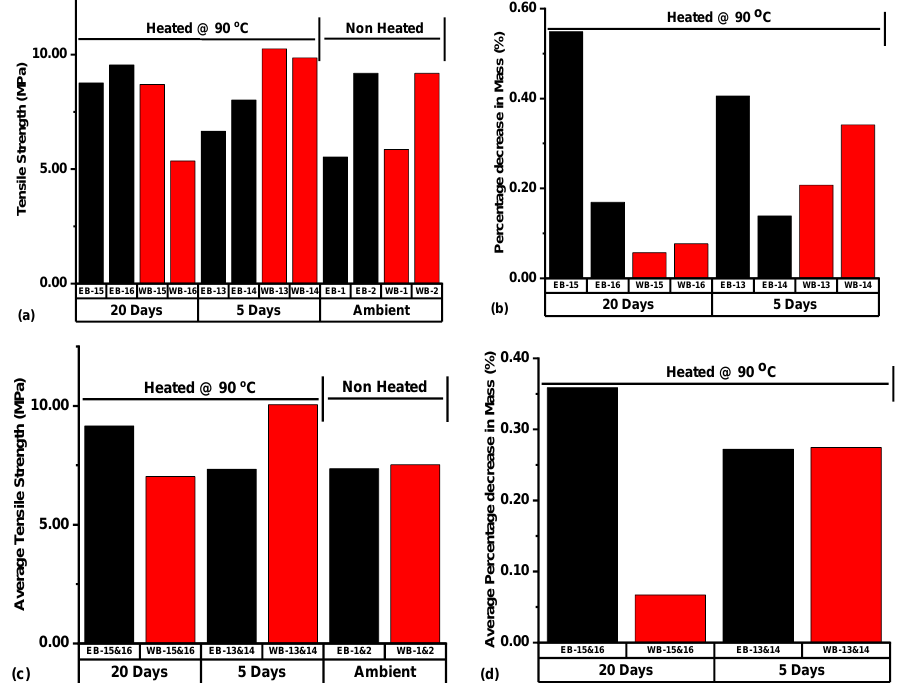
Figure 19. ( a ) Tensile strength, ( b ) Percentage decrease in mass, ( c ) Average tensile strength (ATS), and ( d ) Average percentage decrease in mass (APDM) distributions of samples subjected to different treatment conditions prior to BITS testing. Notes contained in Figure 14 still apply. Eagle Ford and Wolfcamp shale samples were exposed to 220 °C, considered as the upper limit of reservoir temperature, for a period of 5 days, with the resulting samples’ tensile strengths compared to those of ambient samples (Figure 20a). The associated per- centage decreases in mass resulting from the thermally exposed samples are represented in Figure 20b. Eagle Ford sample EB-18, subjected to 5 days of thermal exposure to 220 °C recorded a percentage decrease in mass of 0.77% and an associated tensile strength of 5.87 MPa. EB-17 had a percentage decrease in mass of 0.25% and a resulting tensile strength at 7.95 MPa. The Wolfcamp sample WB-18 under the same heat treatment condition had a percentage decrease in mass of 0.06% and a tensile strength of 5.98 MPa. Sample WB-17 recorded a percentage decrease in mass of 0.02% and a tensile strength at 8.27 MPa (Figure 20a,b). The higher values of percentage decrease in mass resulting from 5 days of thermal exposure of the Eagle Ford and Wolfcamp shale samples to 220 °C were associated with lower tensile strength values. The ATS value of Eagle Ford samples EB-17 & 18 after 5 days of thermal exposure to 220 °C was 6.91 MPa, and the associated APDM was 0.51%. This ATS value represented a decrease of 6.11% with reference to that of ambient samples EB-1 & 2, at an ATS of 7.36 MPa (Figure 20c,d). In the case of Wolfcamp samples WB-17 & 18, with an APDM at 0.04%, the ATS was 7.12 MPa and thus represented a decrease of 5.32% with reference to that of ambient samples WB-1 & 2. These results demonstrated that 220 °C thermal exposure of